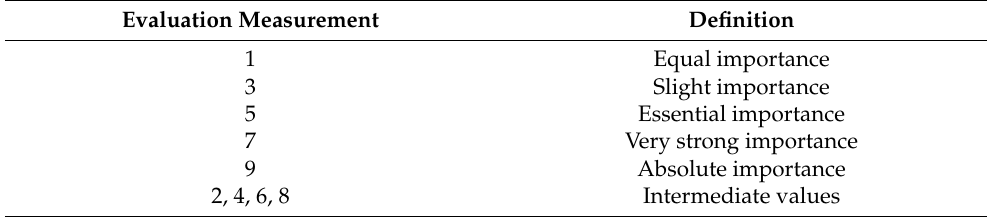
Table 1. Evaluation measurement and relative definition of the analytic hierarchy process.